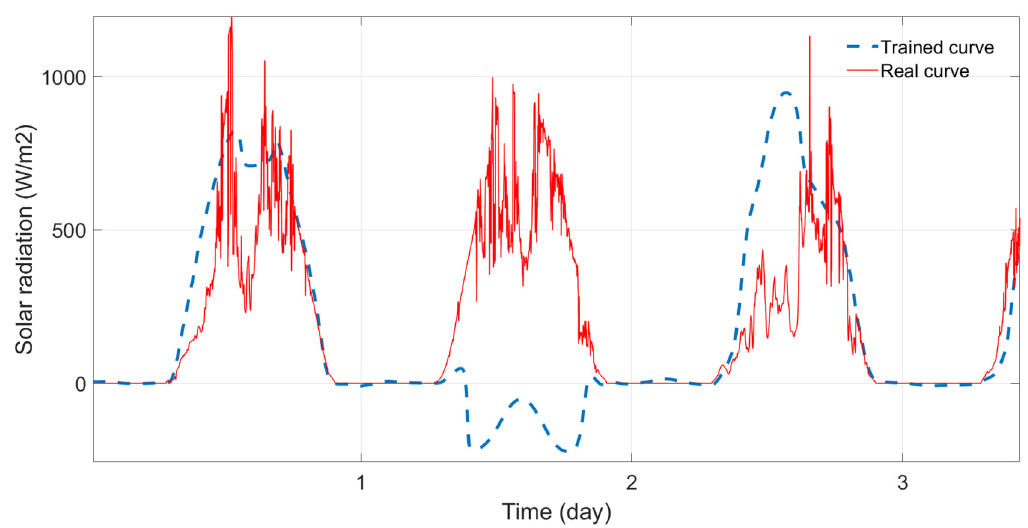
Figure 13. Training result in the case of the use of linear activation function in the output layer.